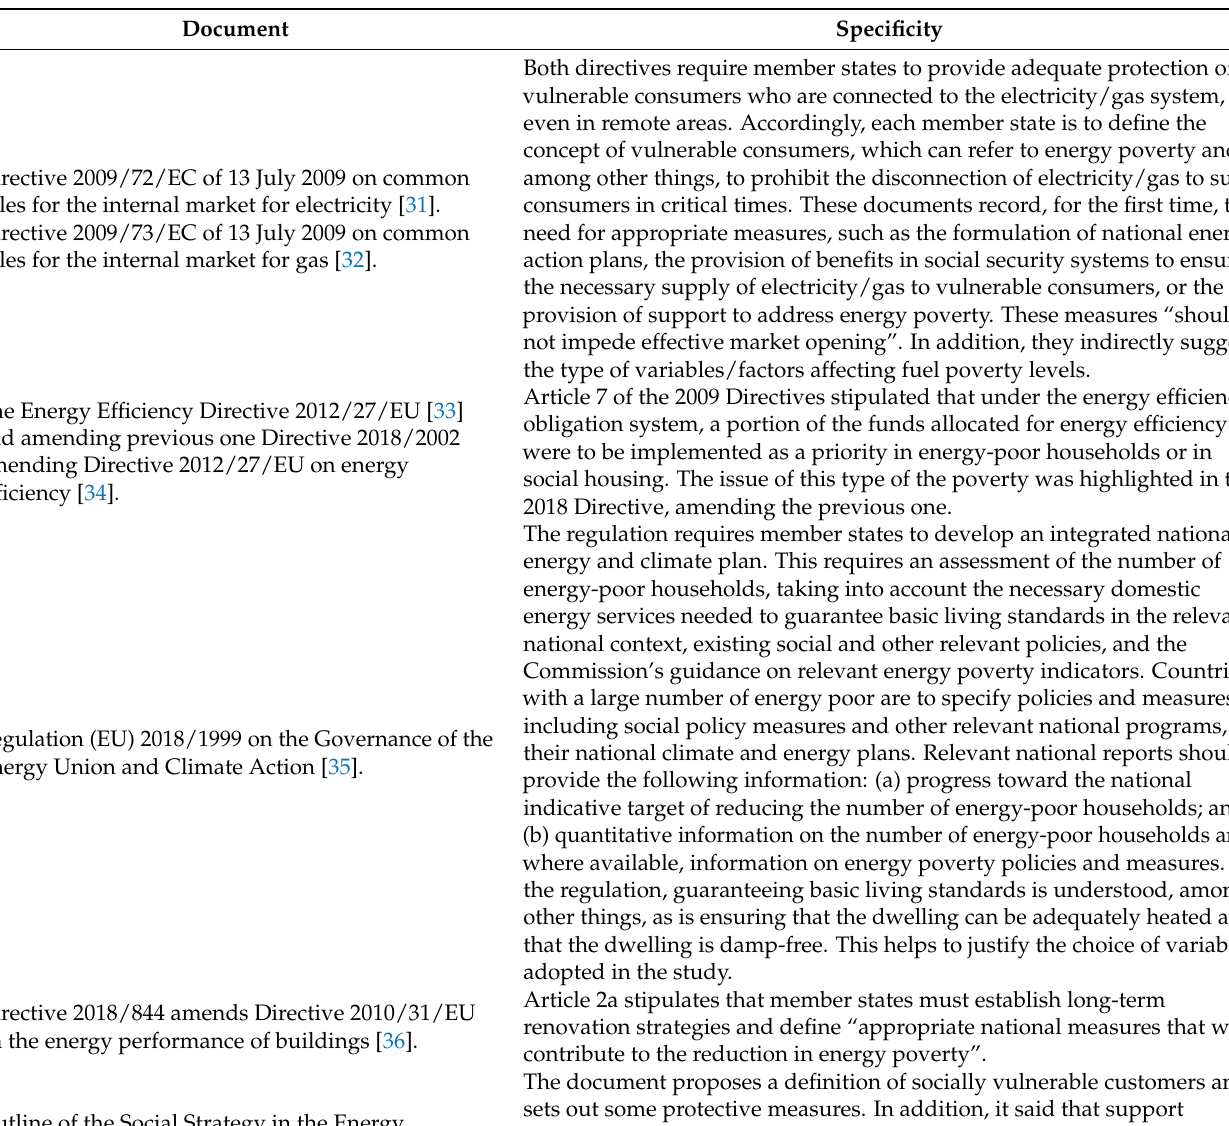
Table 1. Key EU regulations on energy poverty and